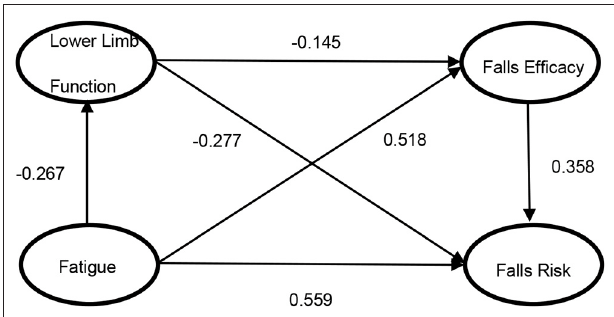
FIGURE 3 | Graphical representations of Final Structural Equation Modeling (SEM).